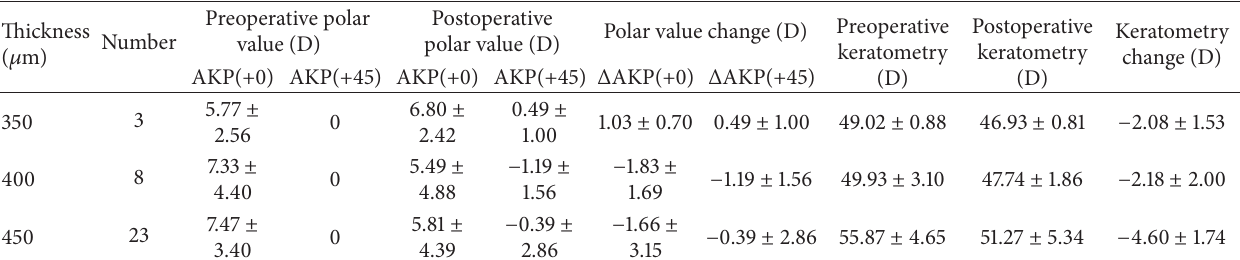
Table 3: Subgroup